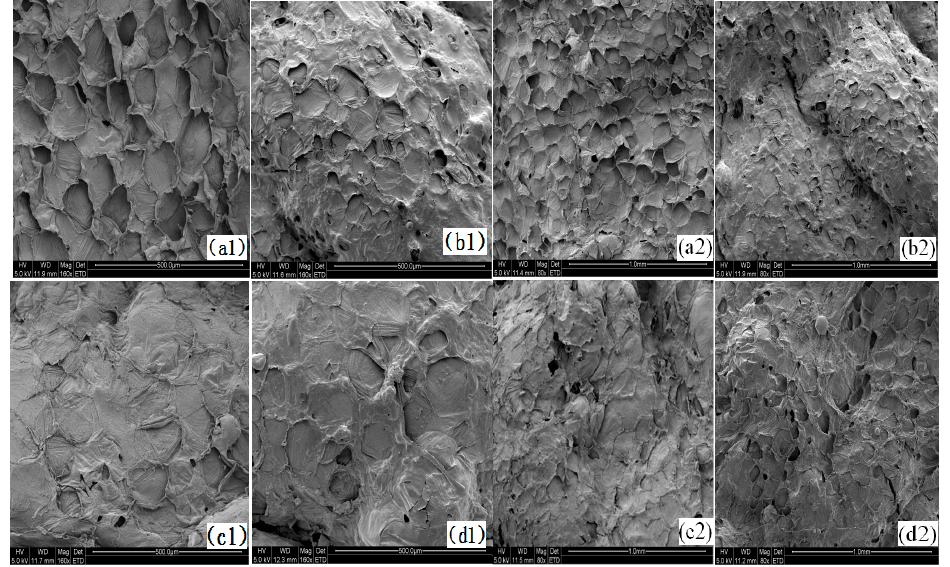
Figure 4. Scan electron microscope photograph of French fries ( a1 , a2 ) means control; ( b1 , b2 ) means coating with guar gum; ( c1 , c2 ) means blanching with calcium ion coating with guar gum; ( d1 , d2 ) means blanching with calcium ion coating with guar gum and sorbitol; left means ×160, right ×80.